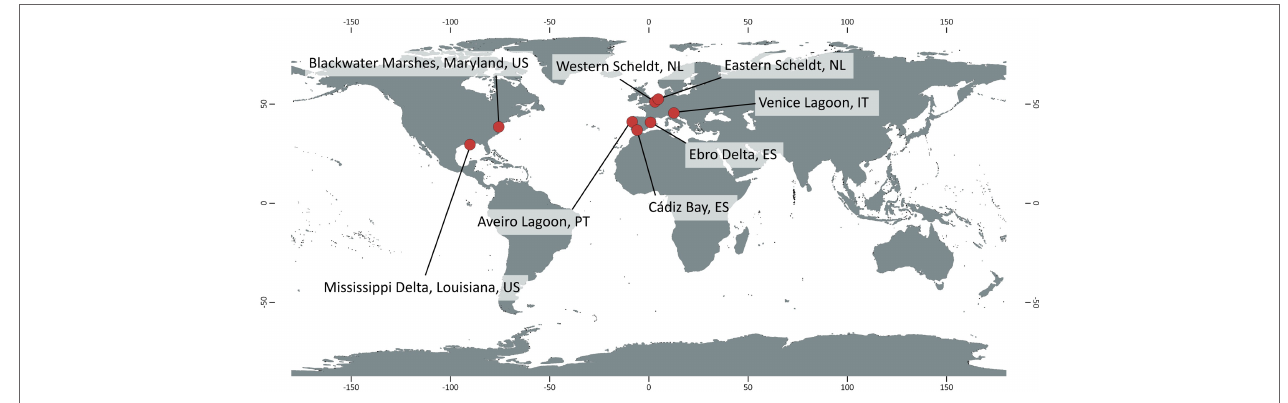
FIGURE 1 | World background made with Natural